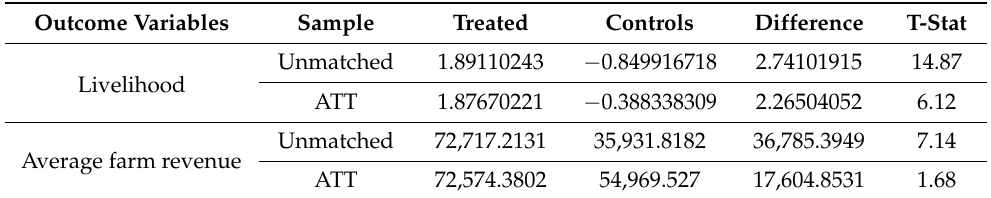
Table 6. Propensity score matching results of the impact of cultivating indigenous fruits and vegeta- bles on households’ livelihood